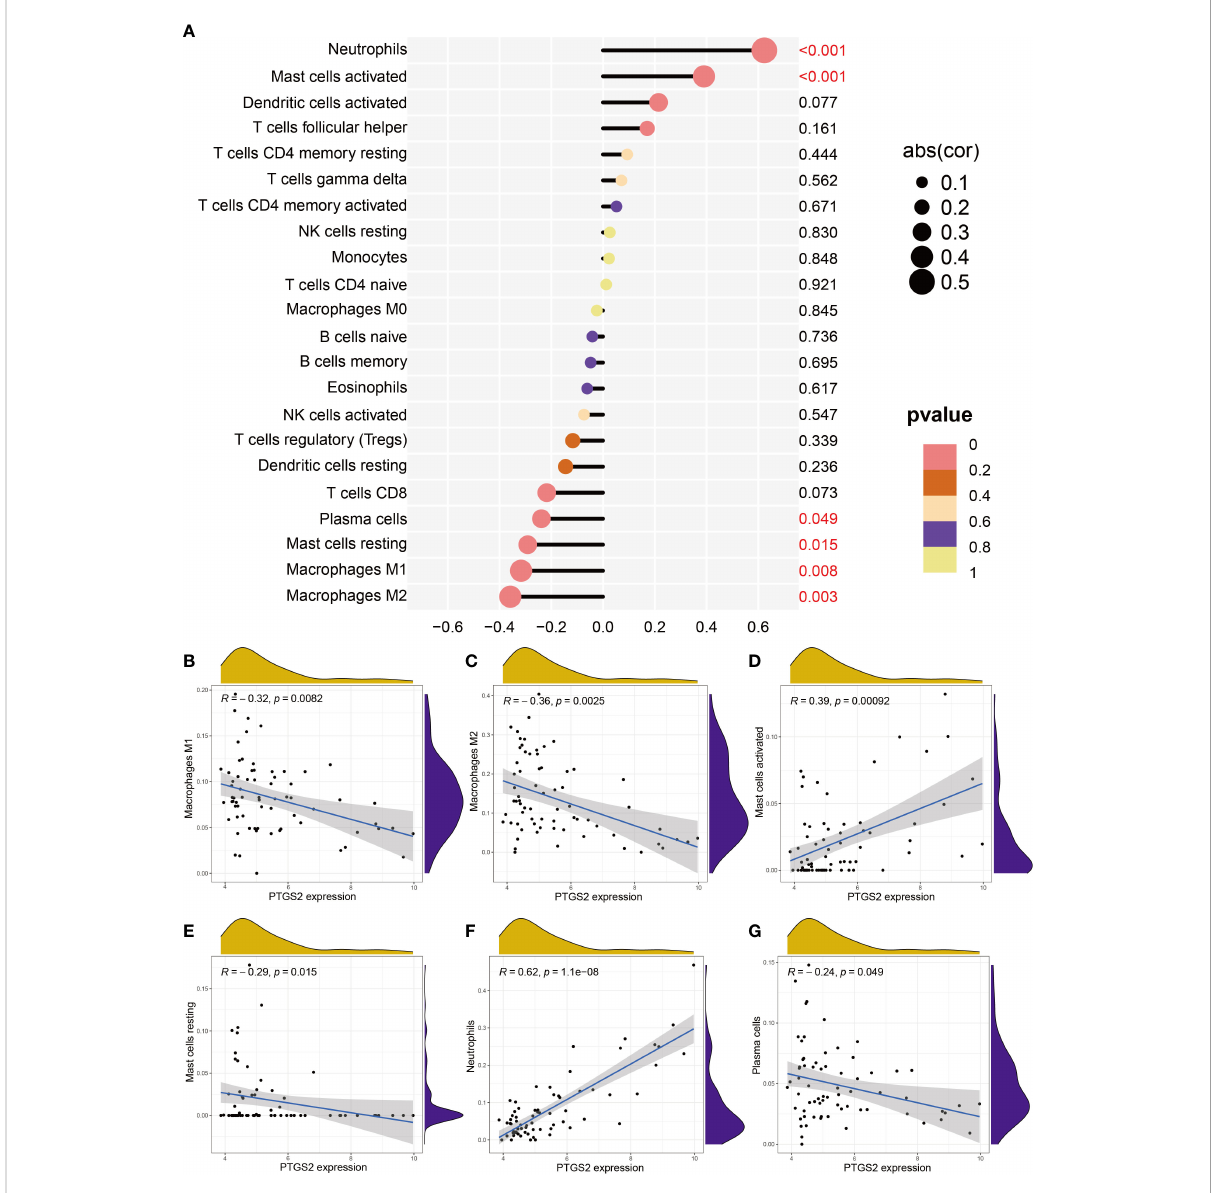
FIGURE 9 Correlation between expression PTGS2 expression and different immune cell in fi ltration degree in DN. (A) Lollipop plot. (B – G) Correlation between expression of PTGS2 and (B) M1 macrophages expression, (C) M2 macrophage expression, (D) activated mast cell expression, (E) resting mast cell expression, (F) neutrophil expression, and (G) plasma cell